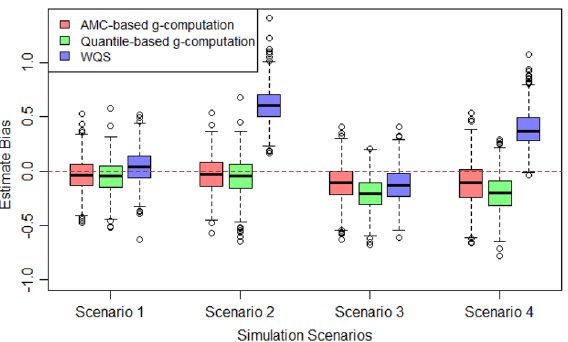
Figure 1. The estimate bias of the mixture effect. Bias = ψ estimate − ψ true . ψ was the effect of the mixture. Bias was calculated across 1000 simulations. The sample size of each exposure was 200. For more details of the meaning for parameters and simulation design, please refer to the “Methods and materials”. Scenario 1: Equal proportions: α j 0 = α j 1 = α j 2 = α j 3 = 0.25 ; Effects are both positive: β 1 = β 2 = 0.5 ; ψ true = 1 Scenario 2: Equal proportions: α j 0 = α j 1 = α j 2 = α j 3 = 0.25 ; Effects are positive and negative: β 1 = 1.5, β 2 = − 0.5 ; ψ true = 1 Scenario 3: Unequal proportions: α j 0 = 0.4, α j 1 = 0.3, α j 2 = 0.2, α j 3 = 0.1 ; Effects are both positive: β 1 = β 2 = 0.5 ; ψ true = 1 Scenario 4: Unequal proportions: α j 0 = 0.4, α j 1 = 0.3, α j 2 = 0.2, α j 3 = 0.1 ; Effects are positive and negative: β 1 = 1.5, β 2 = − 0.5 ; ψ true =